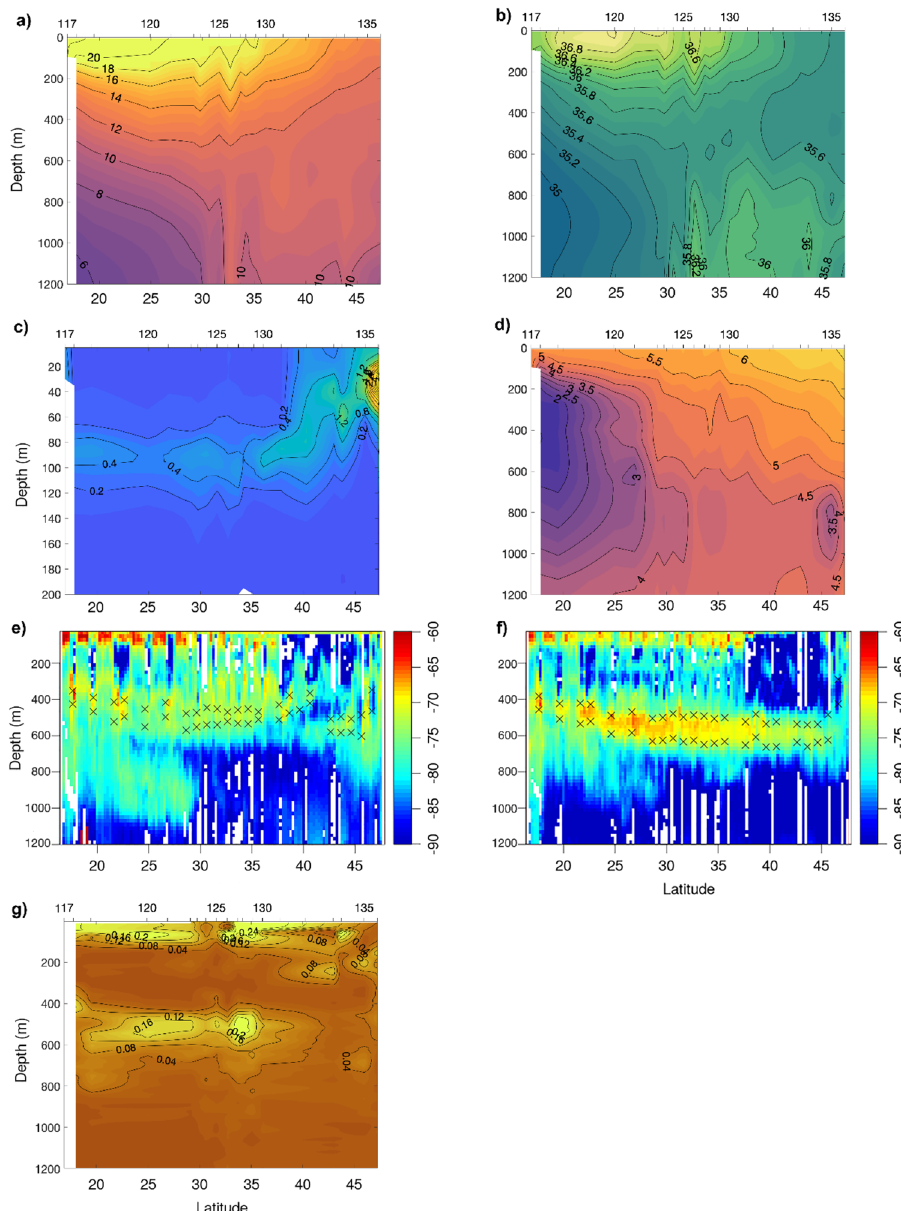
Figure 3. Latitudinal and vertical variation during the cruise transect in ( a ) temperature (°C), ( b ) salinity, ( c ) fluorescence (mg m −3 ), ( d ) oxygen (ml l −1 ), volume backscattering strength ( S v ) (dB re 1 m −1 ) ( e ) at 18 kHz and ( f ) at 38 kHz, ( g ) micronektonic densities (number of echoes m −3 ) estimated using trawl mounted WBAT (120 and 200 kHz). In these plots, the values between stations, with the exception of ( e ) and ( f ), were linearly interpolated between the values at each pair of stations. Note that in ( e ) and ( f ) while all daytime data (sun above horizon) is plotted in the echograms, only data for periods where the sun was more than 50 degrees above horizon were included in the calculation of DSL widths (full-width-half-max relative peak DSL S v levels, marked by X) to reduce the impact of vertical migration on the estimates. For the rest of the graphs, the position of the CTD station numbers is indicated in the upper part. This figure was created using MATLAB, version R2018a from MathWorks (https:// www. mathw orks. com) and R version 4.1.3 (2022-03-10) (https:// www.r- proje ct.